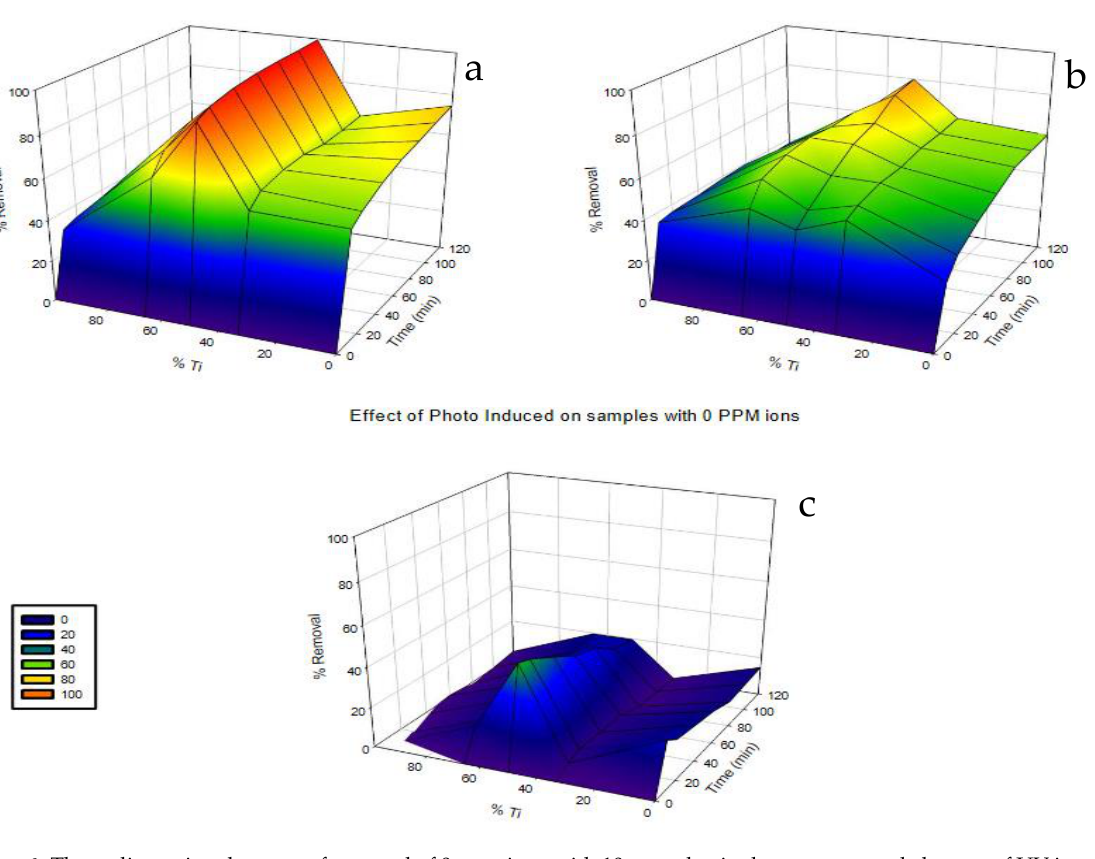
Figure 6. Three-dimensional curves of removal of 0 ppm ions with 10 ppm dye in the presence and absence of UV irradiation and the difference between curves: ( a ) under UV irradiation; ( b ) without UV irradiation; ( c ) two curves difference.